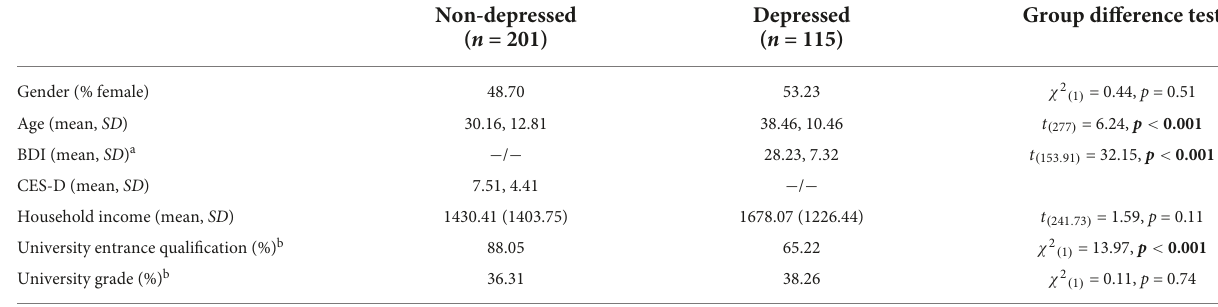
TABLE 1 Participant characteristics by group.